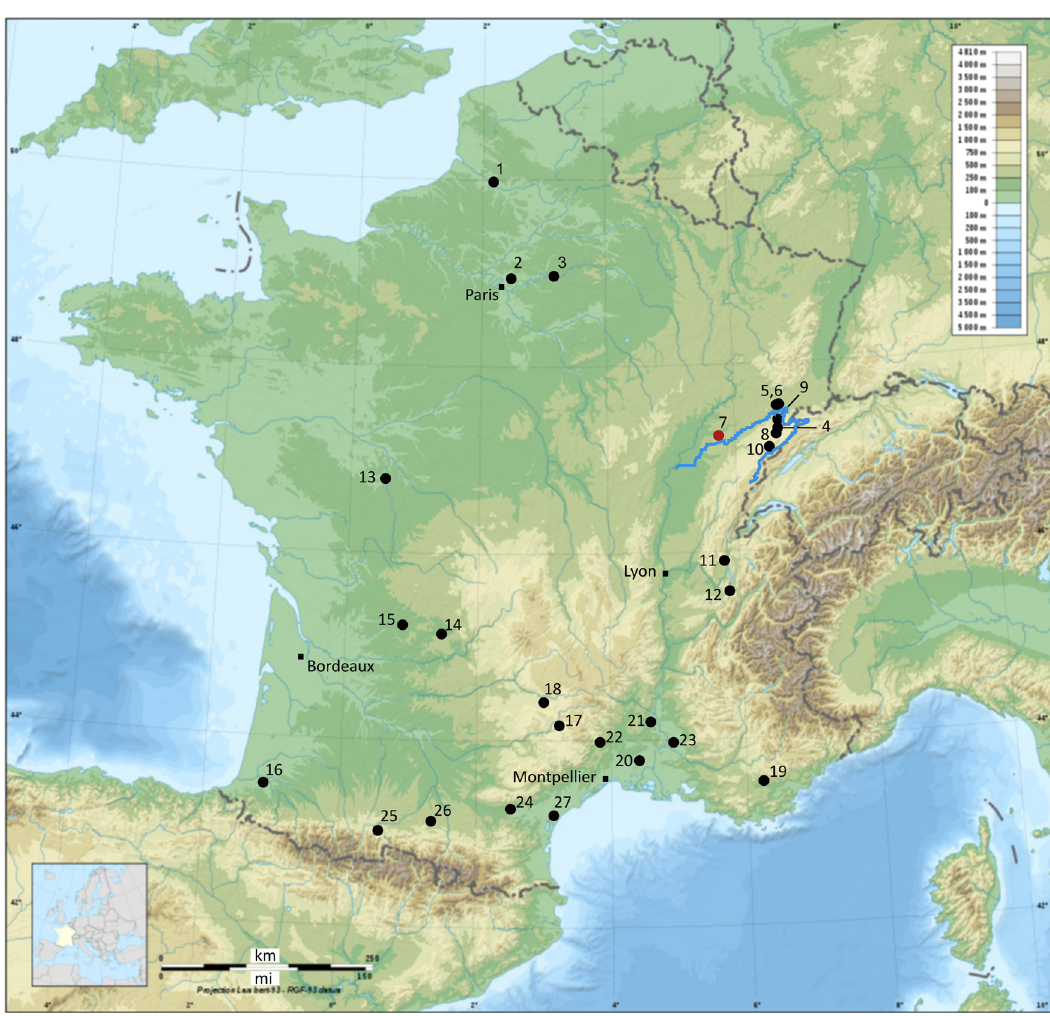
Figure 1: Location of French Mesolithic sites having yielded freshwater fi sh remains ( map of France from cartesFrance.fr ) . ( 1 ) Le Petit Marais, ( 2 ) La Haute - Île, ( 3 ) Le Haut - des - Nachères, ( 4 ) Baume de Montandon, ( 5 ) Bavans, ( 6 ) Châtaillon, ( 7 ) Les Cabônes, ( 8 ) Gigot, ( 9 ) Rochedane, ( 10 ) La Roche - aux - Pêcheurs, ( 11 ) Sous Balme, ( 12 ) Jean - Pierre 1, ( 13 ) Abri des Rocs, ( 14 ) La Doue, ( 15 ) Le Peyrat, ( 16 ) Bourouilla, ( 17 ) La Poujade, ( 18 ) Roquemissou, ( 19 ) La Baume Fontbrégoua, ( 20 ) Le Plaisir, ( 21 ) La Baume de Montclus, ( 22 ) Grotte du Salpêtre, ( 23 ) Le Mourre de Sève, ( 24 ) Balma de l ’ Abeurador, ( 25 ) Moulin, ( 26 ) Buholoup, and ( 27 ) La Crouzade. The Doubs River is highlighted in blue. Please refer to Table S1 in the supporting information for the